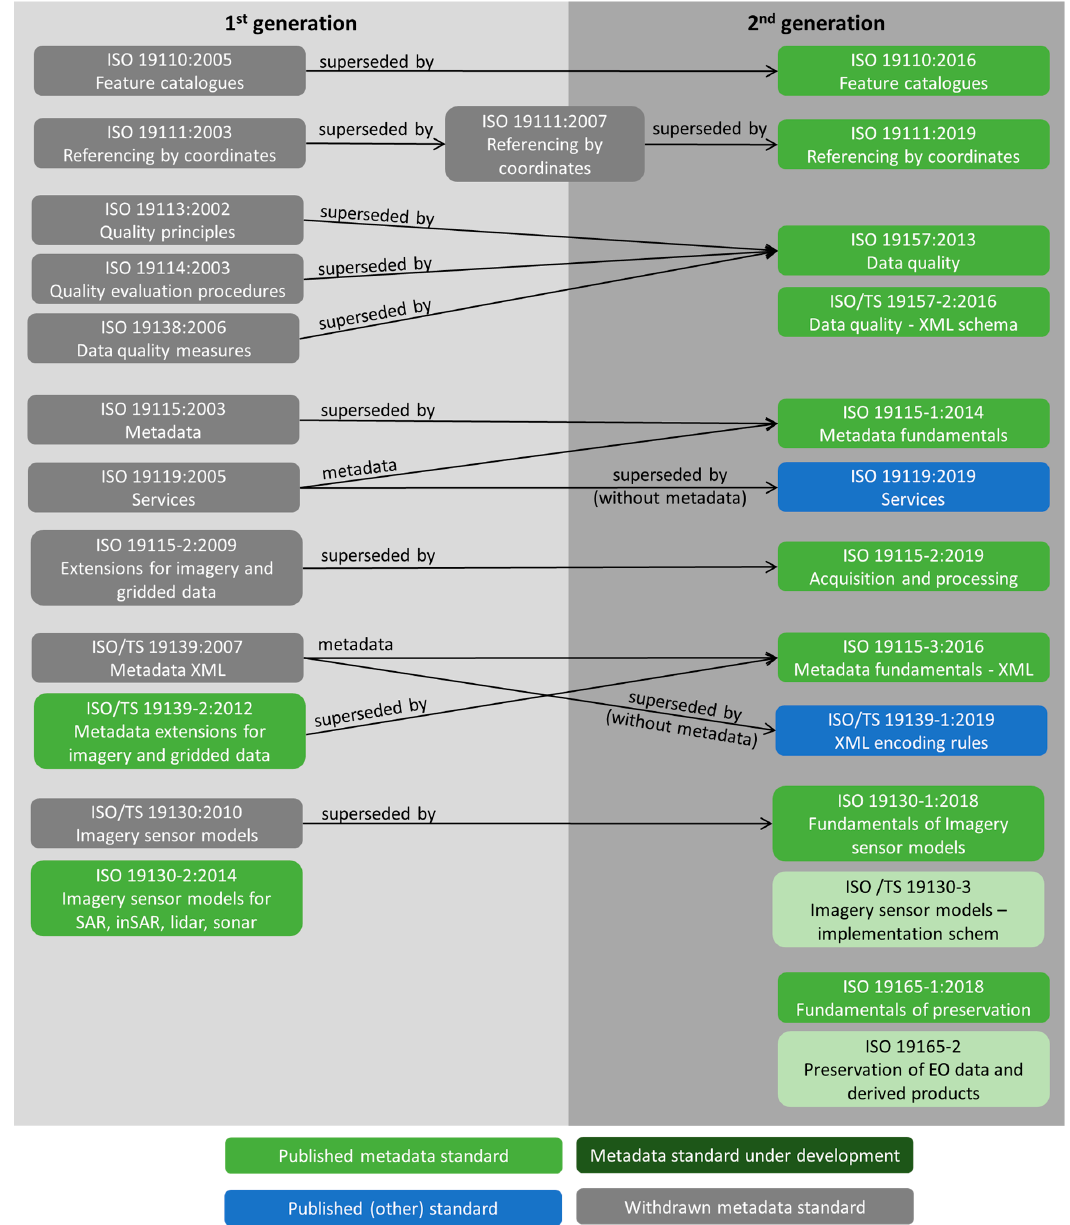
Figure 1. Diagram of the evolution of ISO metadata standards.